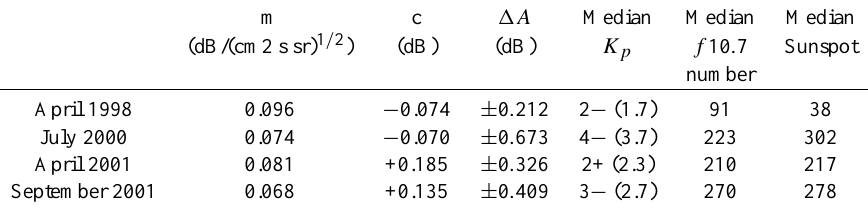
Table 4. Parameters related to the fit of absorption to the square root of the integral proton flux for the four events depicted in Fig. 9. These include (left to right) the gradient, m , intercept, c , median associated error, 1A , and three indices of the geomagnetic ( K p ) and solar ( f 10 . 7cm flux and sunspot number) activity. m c